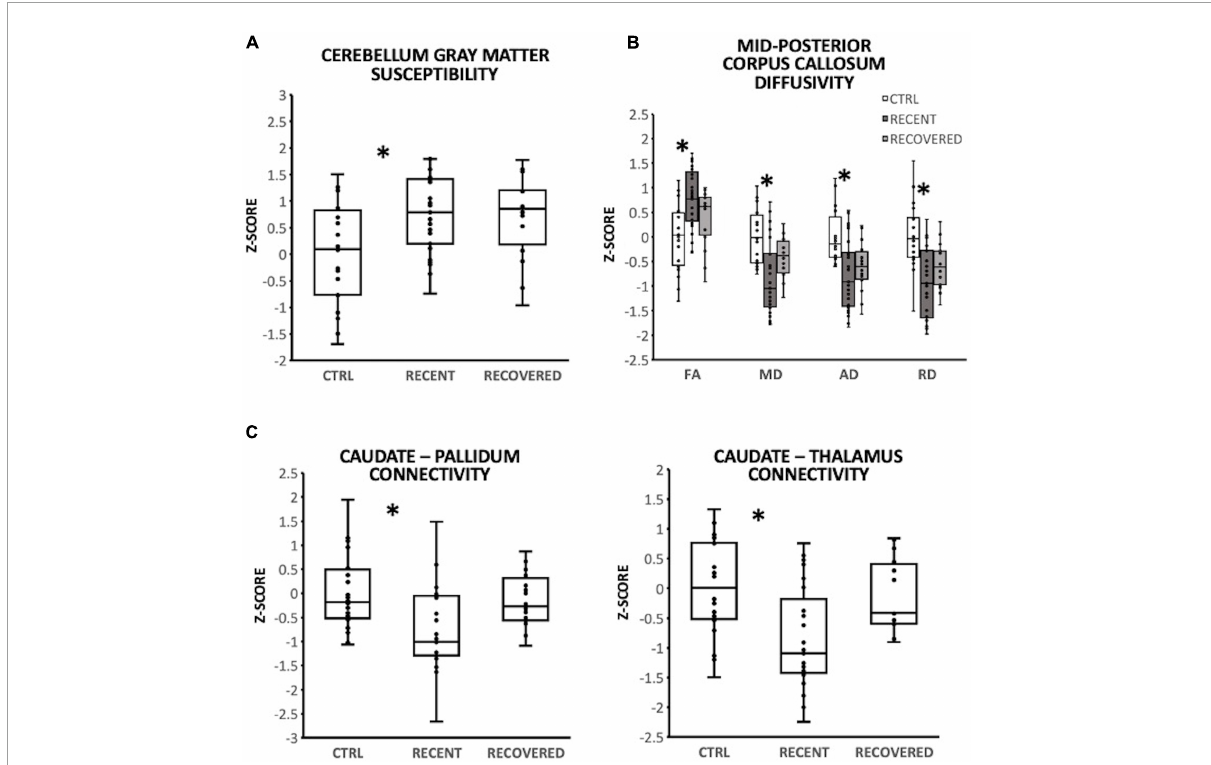
FIGURE1 Group differencesin magnetic resonance imaging (MRI), with individual data plotted as a Z-score relative to the mean of control participants (CTRL; N = 20). ∗ Indicate a significant difference ( p < 0.05) between recently concussed youth and control participants. Relative to control participants (CTRL, N = 20), recently concussed youth (RECENT, N = 29) exhibited: (A) significantly increased susceptibility in the cerebellum gray matter ( p = 0.032); (B) significantly increased FA ( p = 0.038) and reduced MD ( p = 0.017), AD ( p = 0.022), and RD ( p = 0.007) in the mid-posterior corpus callosum; and (C) significantly decreased functional connectivity between the caudate and each of the pallidum ( p = 0.035) and thalamus ( p = 0.021). Youth recovered from SRC (RECOVERED; N = 16) exhibited no significant differences from control